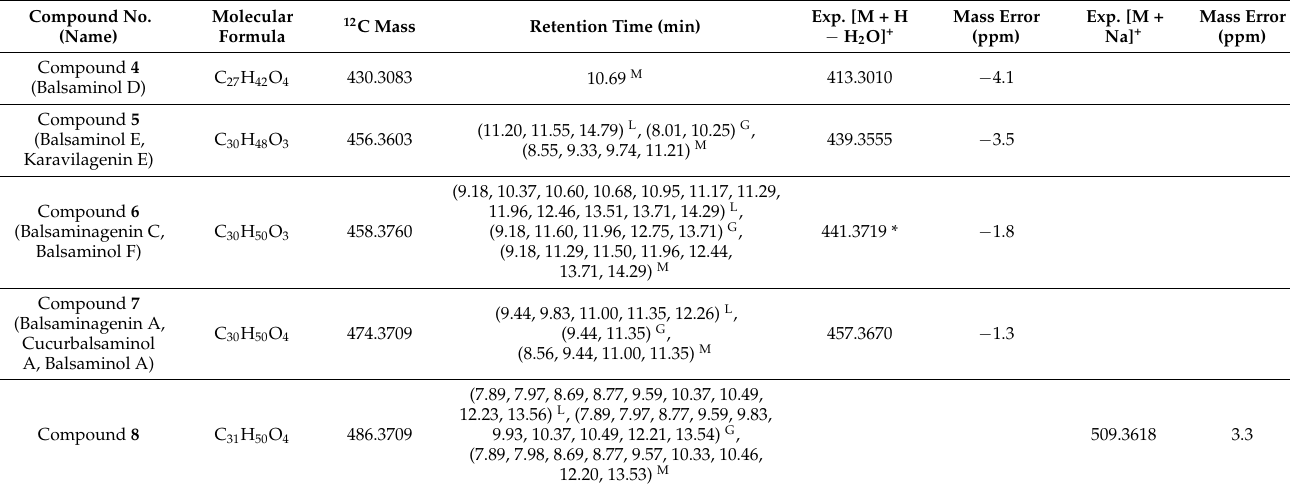
Figure 2. Base peak ion chromatograms obtained for the RP-LC analysis of Momordica balsamina from three different geographic areas in South Africa, named Letsitele ( A ), Goedplaas ( B ) and Mankweng ( C ). Peak labels correspond to Tables 1–3. Table 2. Cucurbitane-type Triterpenoid Aglycones Identified in M. balsamina using